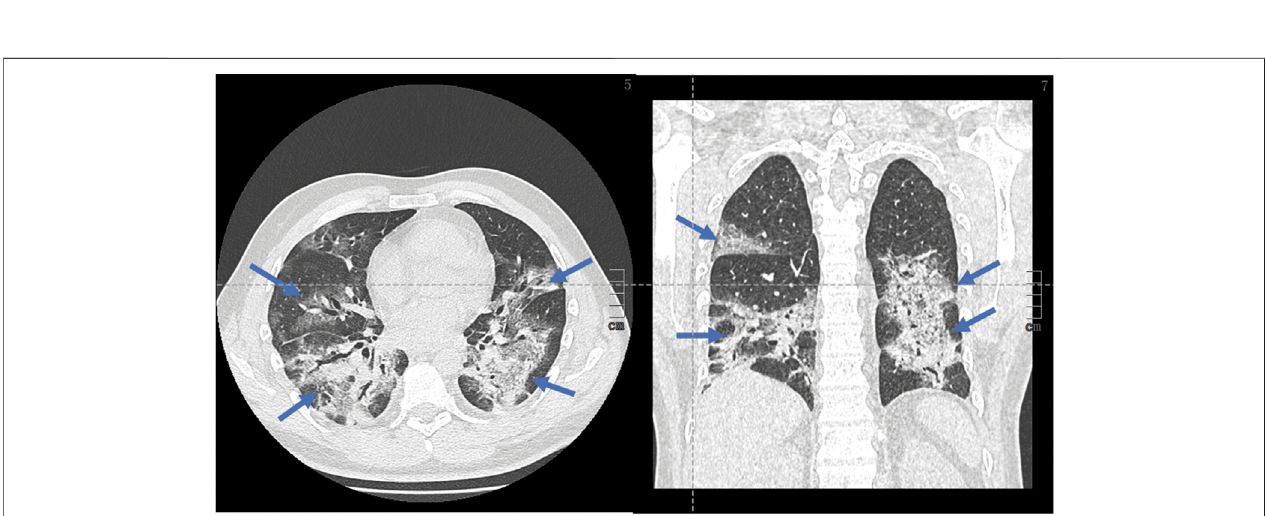
Frontiers in Pharmacology |